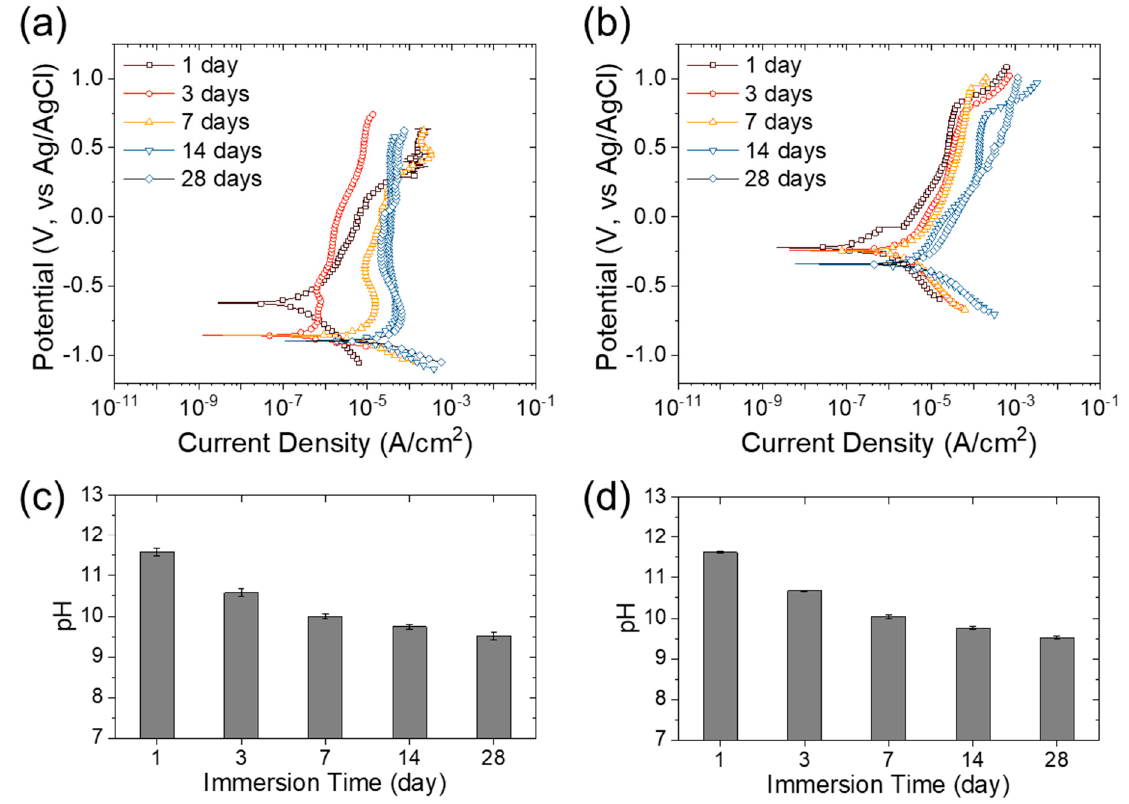
Figure 7. Potentiodynamic polarization curves of ( a ) S400 and ( b ) Fe-based shape memory alloy (FSMA) inserted in mortar in a 3.5 wt.% NaCl solution with various long-term immersion durations. pH of 3.5 wt.% NaCl solutions in which ( c ) S400- and ( d ) FSMA-inserted mortar was immersed for 28 days. Table 5. Estimated free corrosion potential (E corr ), free corrosion current density (i corr ), and polarization resistance (R p ) of S400 and Fe-based shape memory alloy from the potentiodynamic polarization curves in Figure 7.